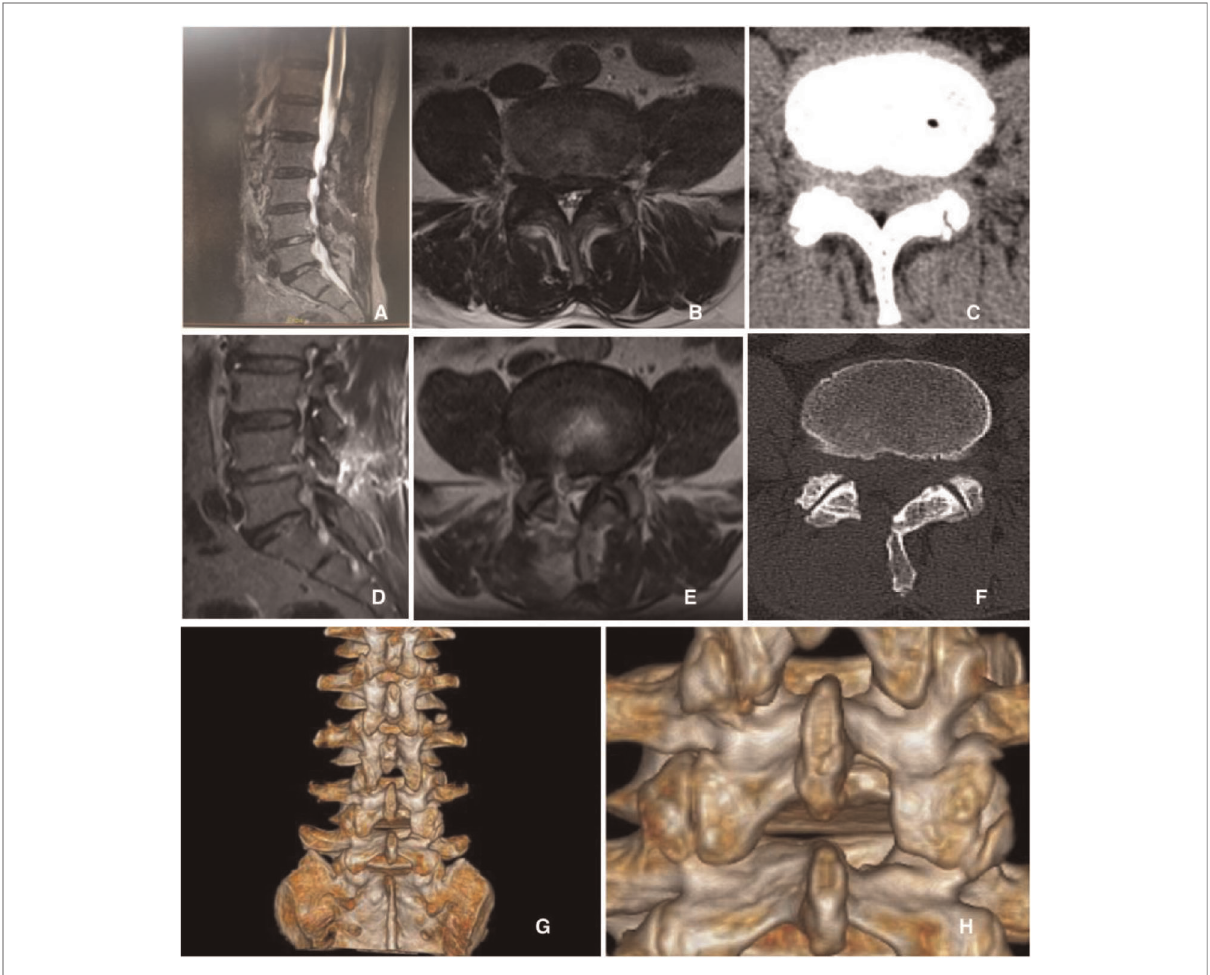
FIGURE 7 Pre-and postoperative radiologic images of the sixth case. A 58-year-old man presented with lateral recess and cranial level foraminal stenosis on the L4 – L5 level. He underwent UBE-CIA on the right side of the L4 – L5 level. Preoperative images showed foraminal stenosis on the right side of the L4 – L5 level ( A – C ); ideal foraminal decompression with an obliquely undercut facet joint was shown in postoperative images ( D – F ); and three- dimensional computed tomography scan identi fi ed the remained facet joints and the range and adequacy of foraminotomy ( G , H